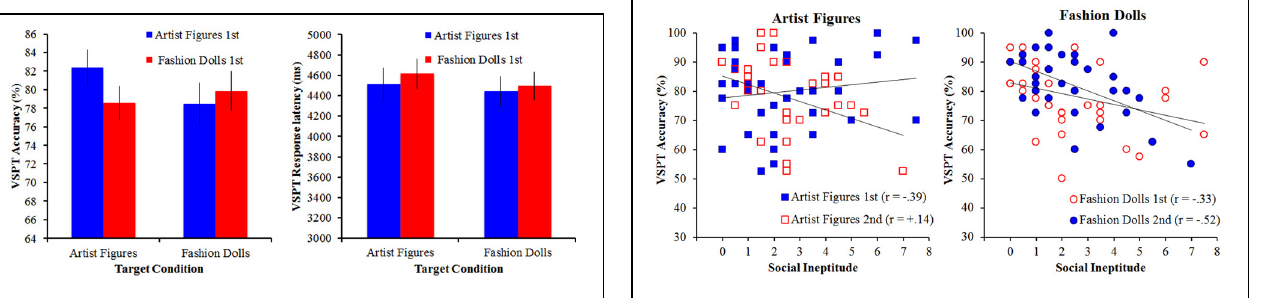
FIGURE 5 | VSPT performance (mean accuracy and response latency) as a function of the target conditions for Experiment 2. Error bars reflect ± 1 standard error of the mean.